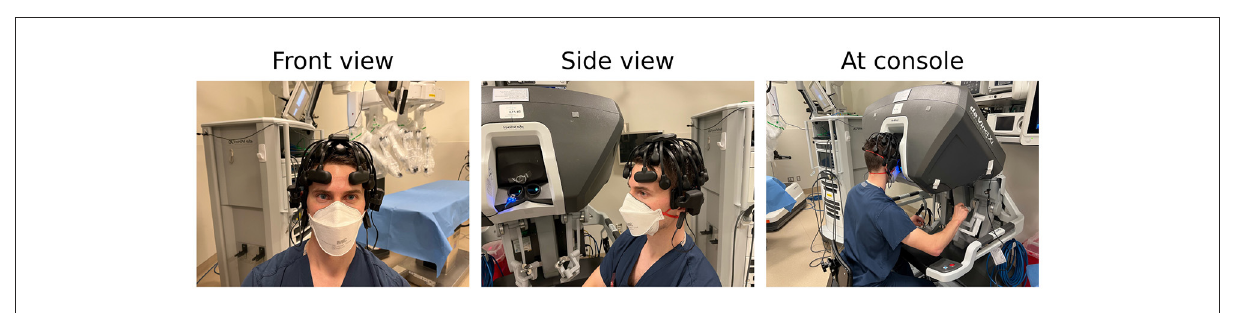
FIGURE2 EEG headset deployed in RAS-equipped